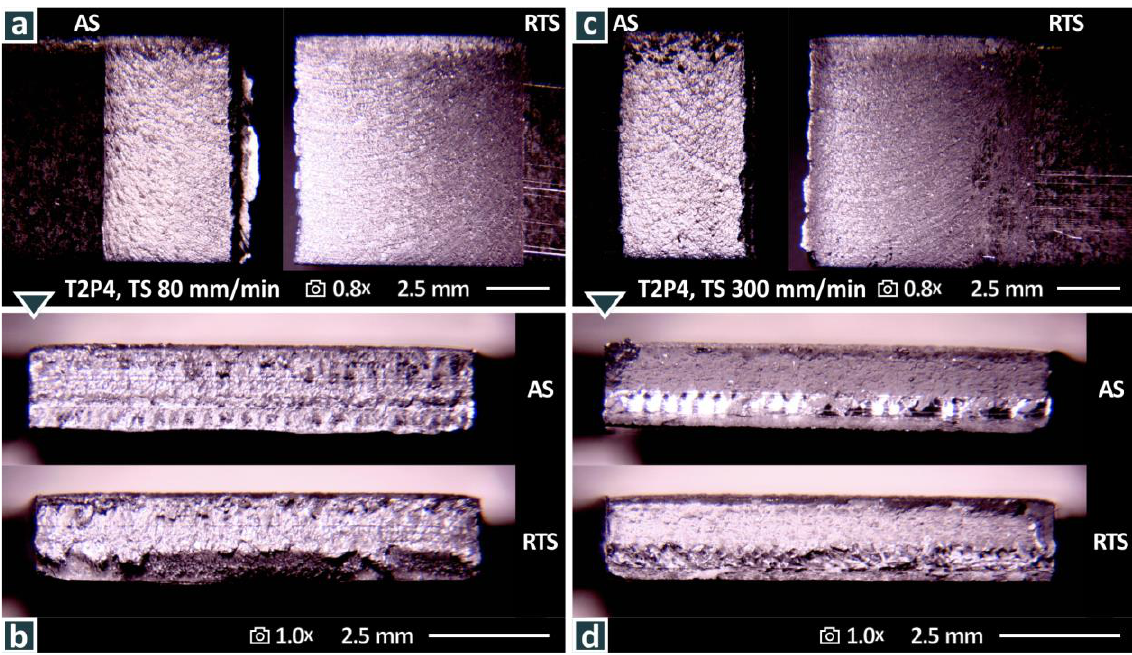
Figure 11. Stereoscopic microscopy images for the T2P4 weld tool at weld speeds of 80 mm/min: ( a ) top surface, ( b ) fracture surface; and 300 mm/min: ( c ) top surface, ( d ) fracture surface.